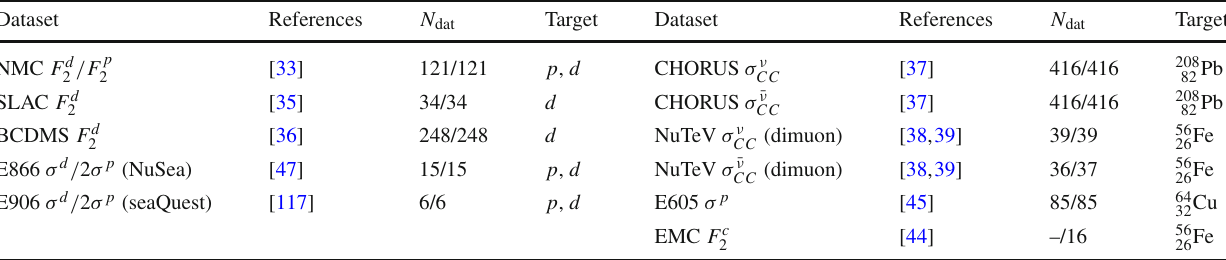
Table 6 The nuclear datasets in NNPDF4.0 involving deuterium targets (left) or heavier nuclear targets (right) and corresponding targets; N dat denotes the number of data points included in the NLO/NNLO fits. Note that the EMC F c